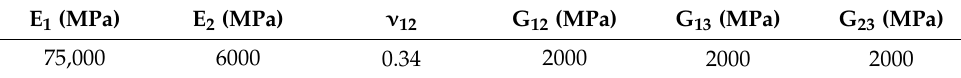
Table 2. Mechanical properties of aramid